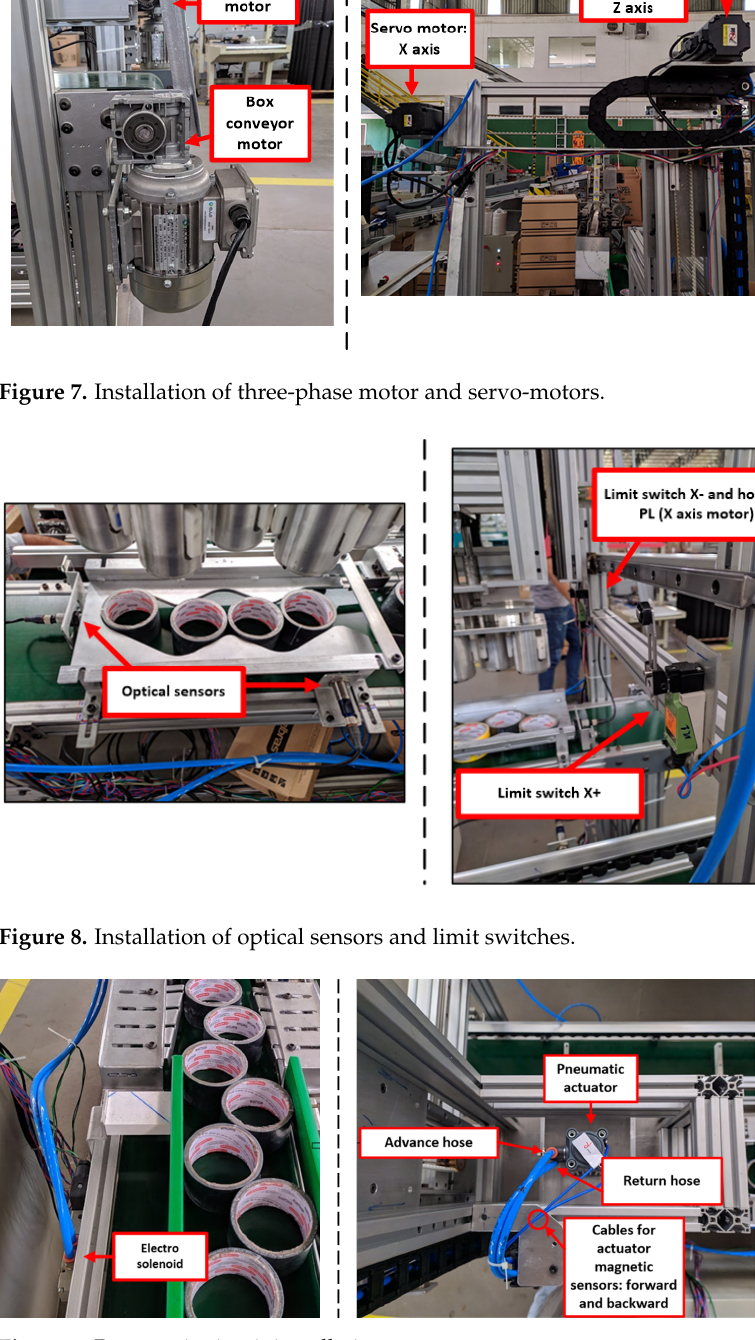
Figure 9. Pneumatic circuit